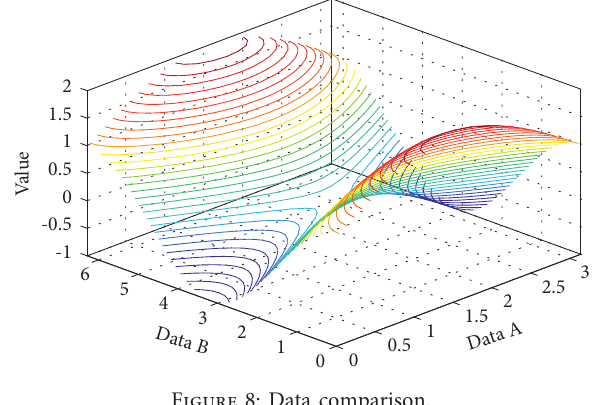
Figure 8: Data comparison.